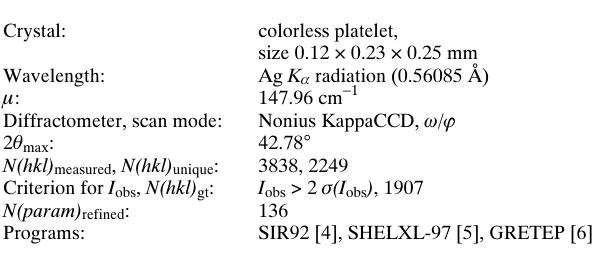
Table 1. Data collection and